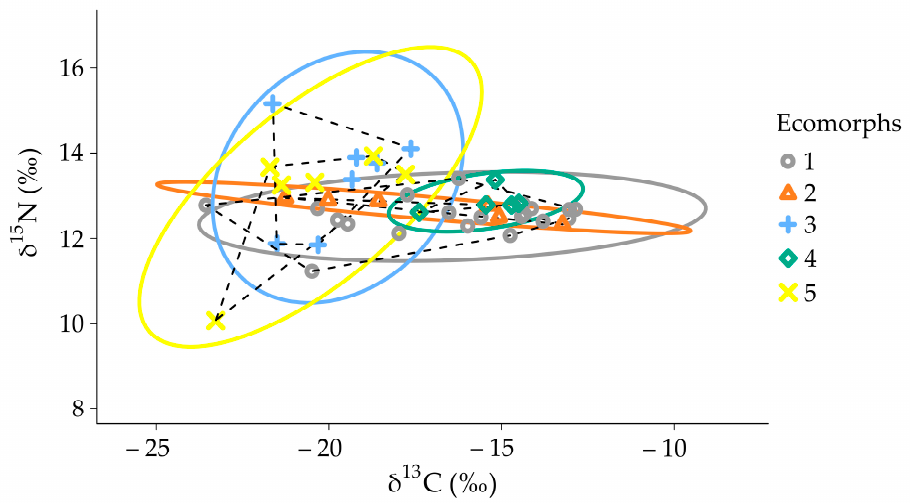
Figure 7. Stable isotope Bayesian ellipses showing the trophic niche widths and overlaps in sympatric ecomorphs of the genus Garra from the Sore River (subset of individuals of 50–90 mm SL, n = 44). Ellipses with 95% credible intervals for the means are based on standard ellipses corrected for small sample sizes (SEAc; isotopic niche metrics; SIBER package). Each mark corresponds to the isotopic values. A broken line connects the extreme points in each sample and delineates the total area (TA). The ecomorphs (1–5) are colored by the same colors as in Figure 5. Table 2. Estimated isotopic niche areas in the sympatric Garra ecomorphs from the Sore River (subset of 50–90 mm SL, n = 44); TA, SEA, and SEAc (SIBER package) are the total area of the convex hull, the standard ellipse area, and the corrected standard ellipse with a correction for small sample sizes, respectively.